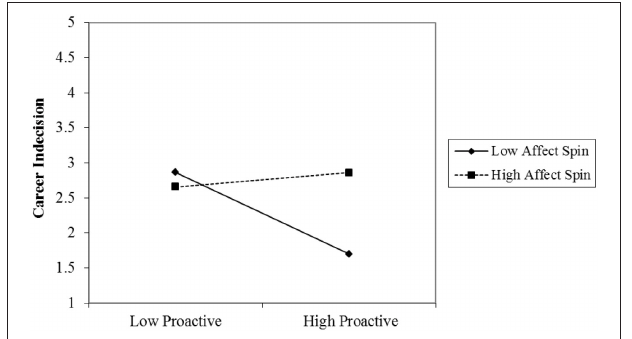
FIGURE 5 | The moderating effect of affect spin in the relationship between proactive personality and career